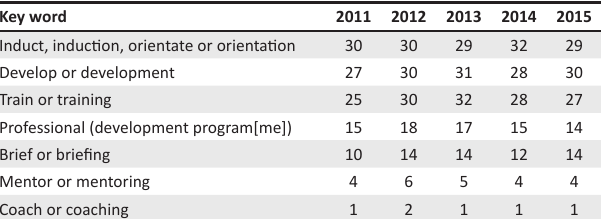
TABLE 2: Reporting on key